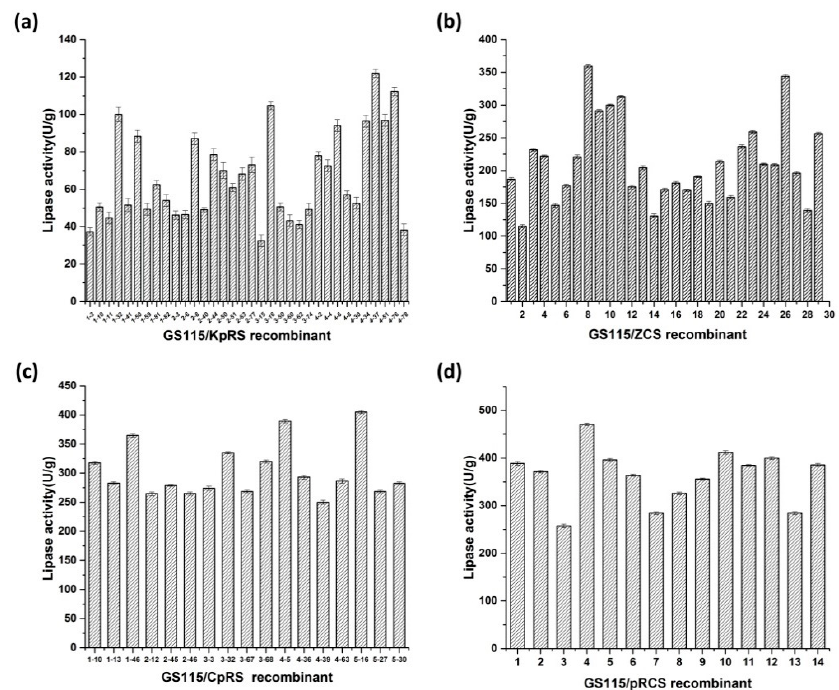
Figure 3. Screening of olive oil hydrolysis by Pichia pastoris GS115/KpRS, GS115/ZCS, GS115/CpRS, and GS115/pRCS in a shake-flask fermentation assay. ( a ) Lipase activity of recombinant GS115/KpRS strains. ( b ) Lipase activity of recombinant GS115/ZCS strains. ( c ) Lipase activity of